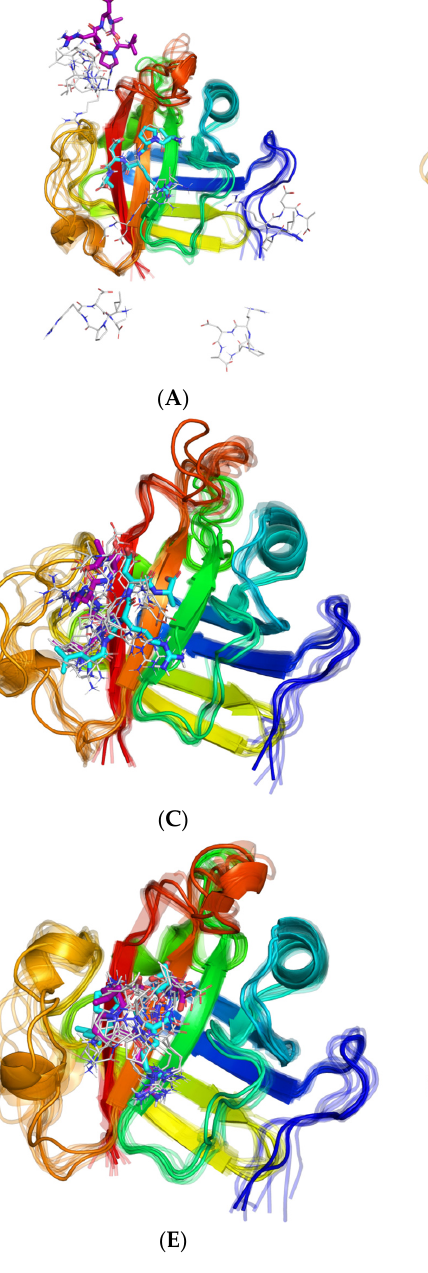
Figure 8. Initial (cyan), intermediate (gray, each 10 ns) and final (magenta) geometries of the “long” 100 ns dynamics for the six different geometries of the LPRDA–SrtA complex. The MD continued for: ( A ) ADV #1 (repl. 1), ( B ) ADV #7 (repl. 1), ( C ) ADV #7 (repl. 3), ( D ) ADV #15 (repl. 1), ( E ) AD #18 (repl. 3), ( F ) AD #20 (repl. 3).